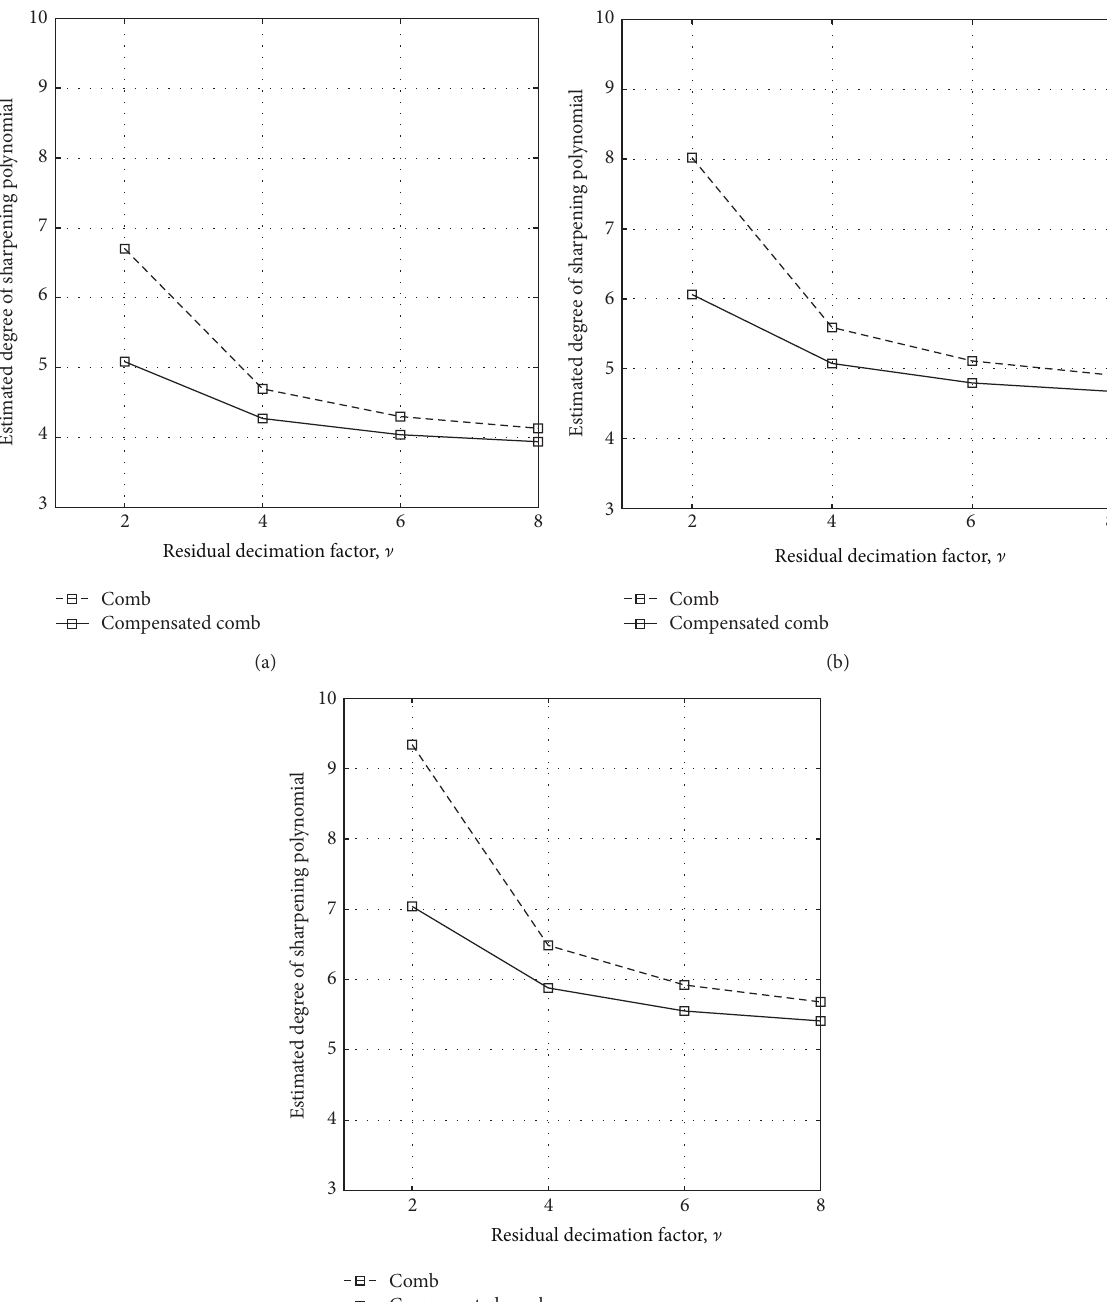
(iv) 𝑑 𝑖,𝑝 and 𝑑 𝑖,𝑠 are the desired amplitudes of the poly- nomial 𝑃(𝑥) at the points 𝑥 = ̃𝑥 𝑖,𝑝 and 𝑥 = ̃𝑥 𝑖,𝑠 , respectively. Usually, 𝑑 𝑖,𝑝 = 1 and 𝑑 𝑖,𝑠 = 0 for all 𝑖 . (v) [ M ] 𝑖,𝑗 denotes the entry in the 𝑖 th row and 𝑗 th column of the underlined matrix M